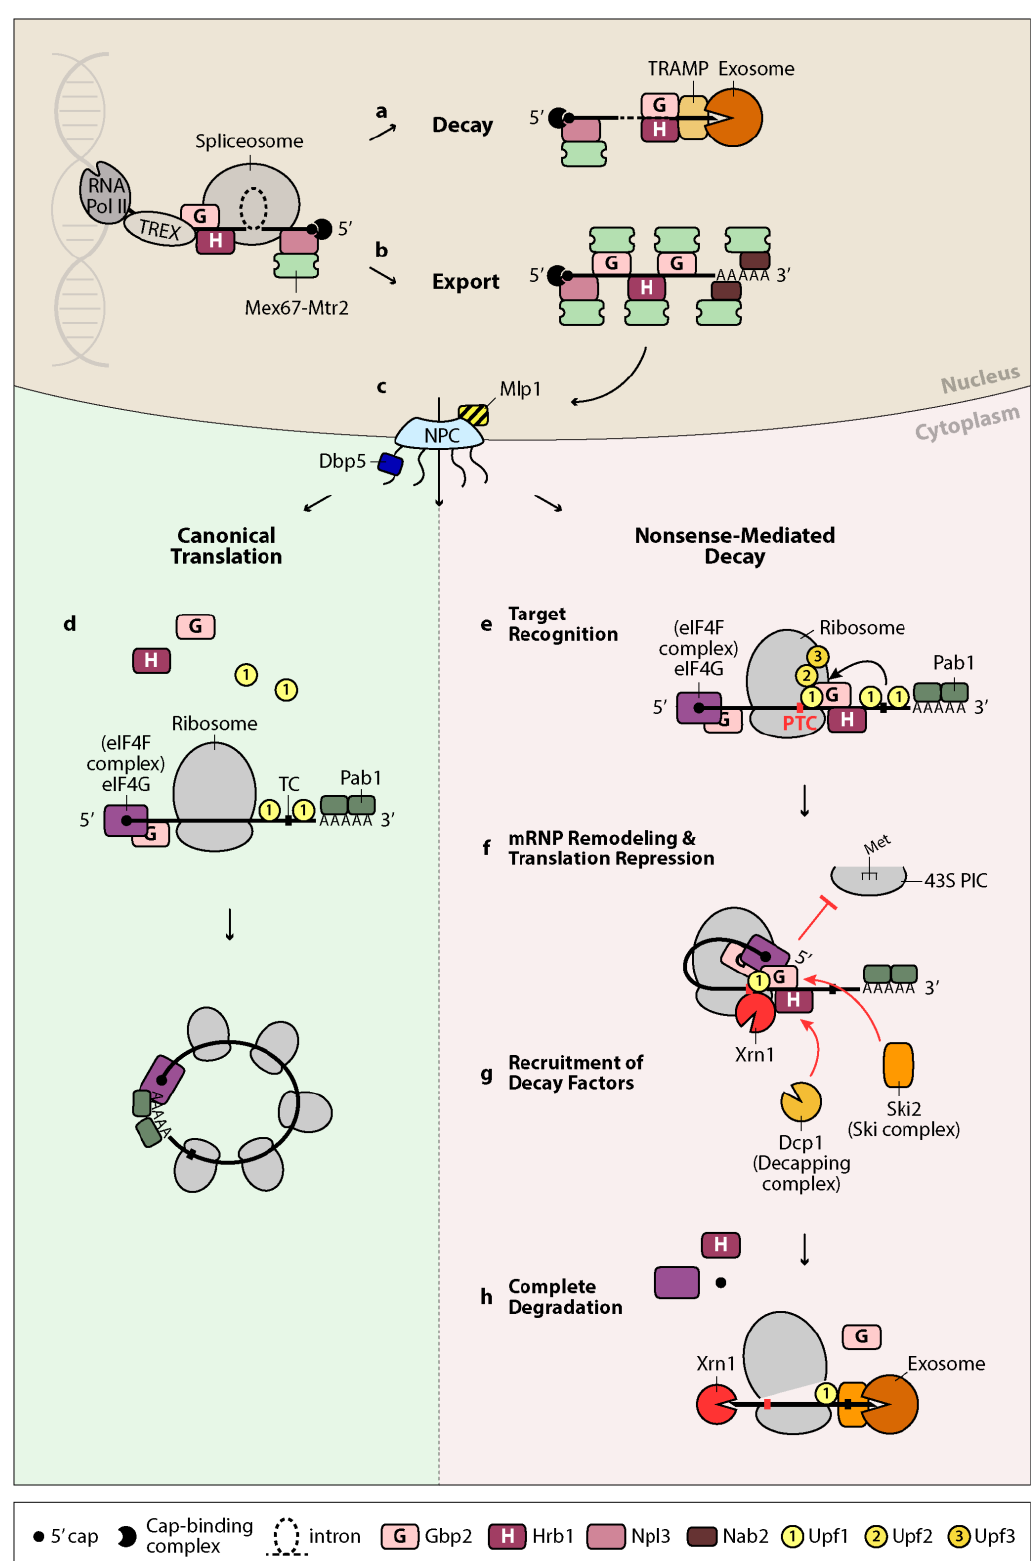
Figure 1. Model for the mRNA quality control functions of Gbp2 and Hrb1. Gbp2 and Hrb1 take part in mRNA quality control both in the nucleus and the cytoplasm. In the nucleus, they are loaded onto the nascent transcript through the TREX complex and associate with the late spliceosome. They recruit the TRAMP complex, which, upon errors in splicing, guides the faulty transcript to the nuclear exosome for degradation ( a ). In the event of correct splicing, Gbp2 and Hrb1 recruit instead the export factor heterodimer Mex67–Mtr2. Npl3 and Nab2 are two other RNA-binding proteins that associate with the mRNA co-transcriptionally. They also directly recruit Mex67–Mtr2, likely upon correct 5′ capping and 3′ polyadenylation, respectively, and together this supports proper packaging of the mature messenger ribonucleoprotein (mRNP) [27,127] ( b ). The mRNP is quality controlled by Mlp1 and other nuclear pore complex (NPC)-associated proteins before export ( c ). At